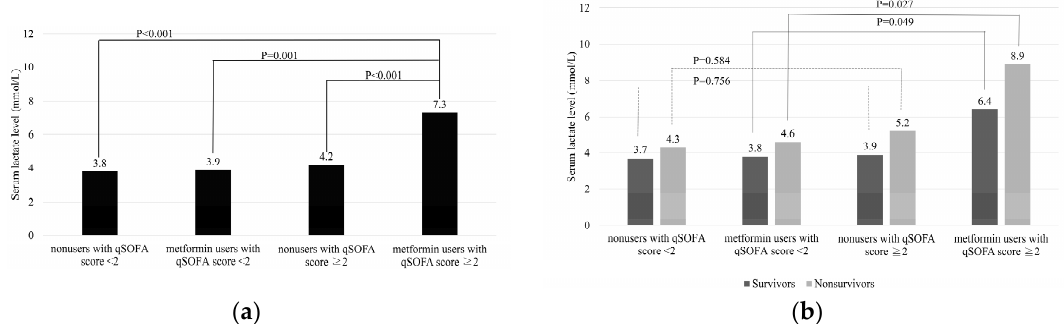
Figure 2. Subgroup analysis by qSOFA score. ( a ) The mean serum lactate level in metformin users with qSOFA score ≥ 2 was significantly higher than that in other groups. Significant difference at p < 0.001 compared with nonusers with qSOFA score ≥ 2 and nonusers with qSOFA score <2; Significant difference at p = 0.001 compared with metformin users with qSOFA score <2. ( b ) The mean serum lactate level was significantly higher in metformin users with qSOFA score ≥ 2 than in metformin users with qSOFA score <2 in both nonsurvivors ( p = 0.027) and survivors ( p = 0.049). No significant difference was found in nonusers with qSOFA score ≥ 2 compared with nonusers with qSOFA score <2 in both nonsurvivors ( p = 0.584) and survivors ( p = 0.756).